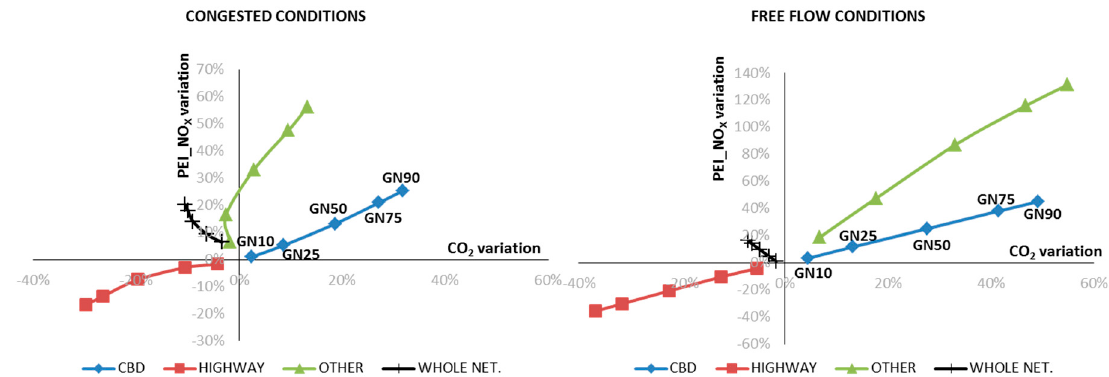
Figure 6. Impacts of the different levels of GN drivers on the spatial allocation of CO 2 emissions and population exposure to NO x by the road type and traffic situation considered. Percentages on each axis indicate the percent variation in each measure with positive percentages indicating an increase and negative percentages indicating a decrease.